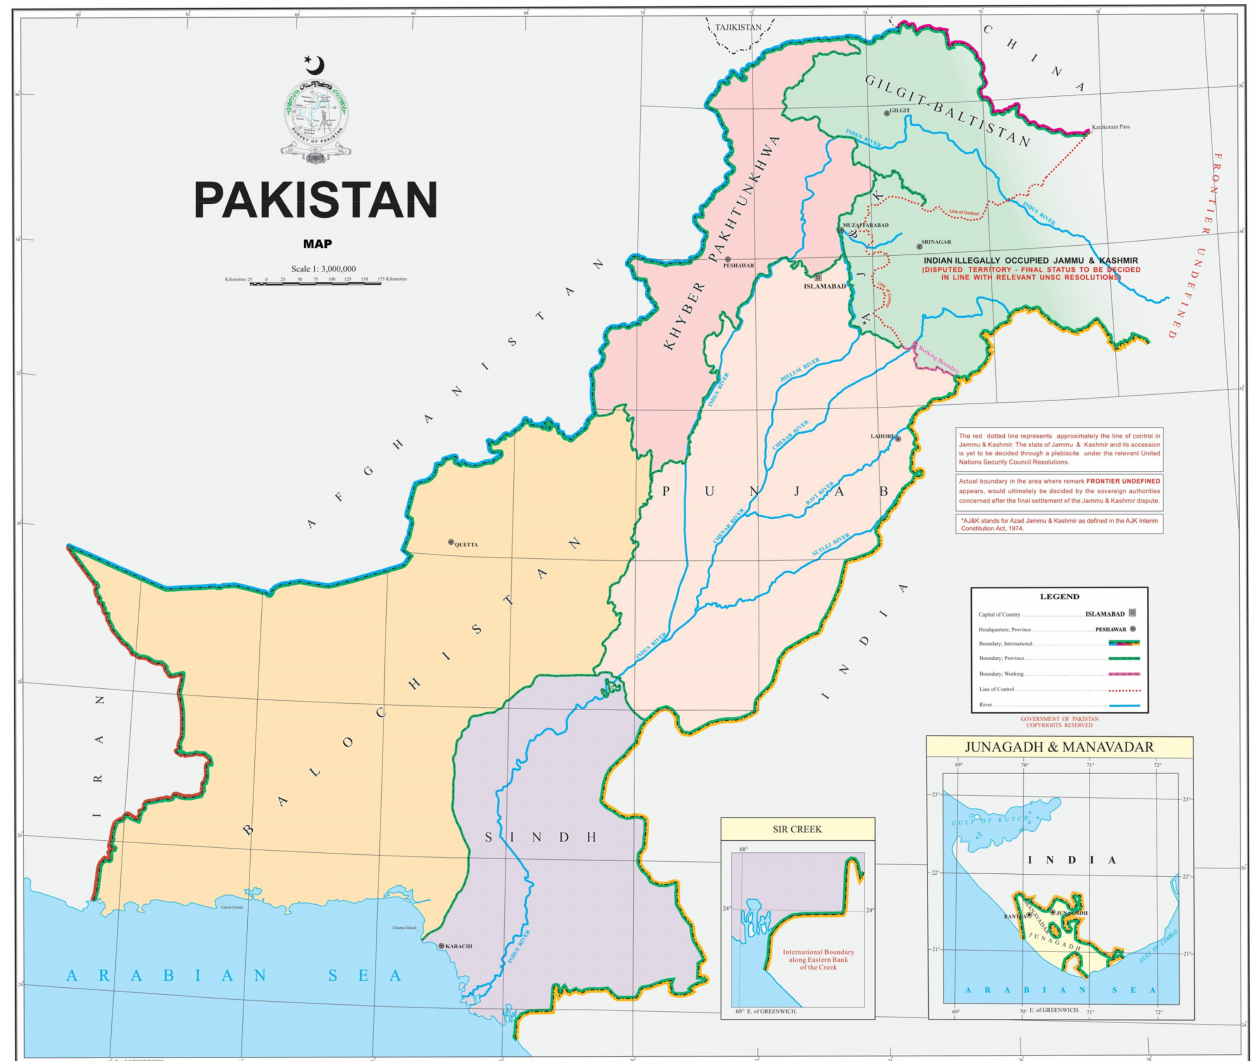
Figure 3. Geographical Boundaries of Pakistan (Survey of Pakistan